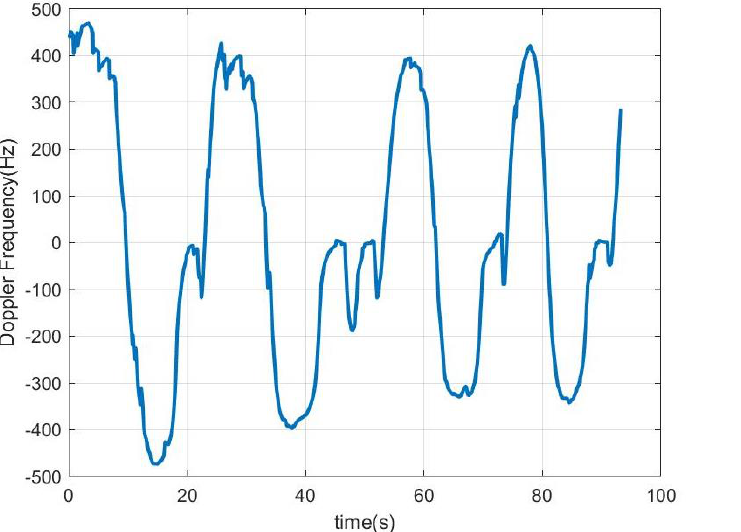
Figure 19. Measurement for a moving scooter sending Barker codes with length 7: scooter Doppler frequency